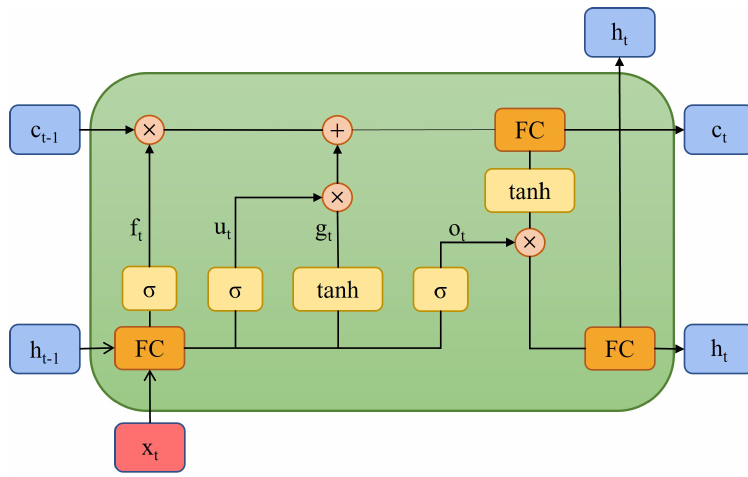
Figure 5. Internal structure of